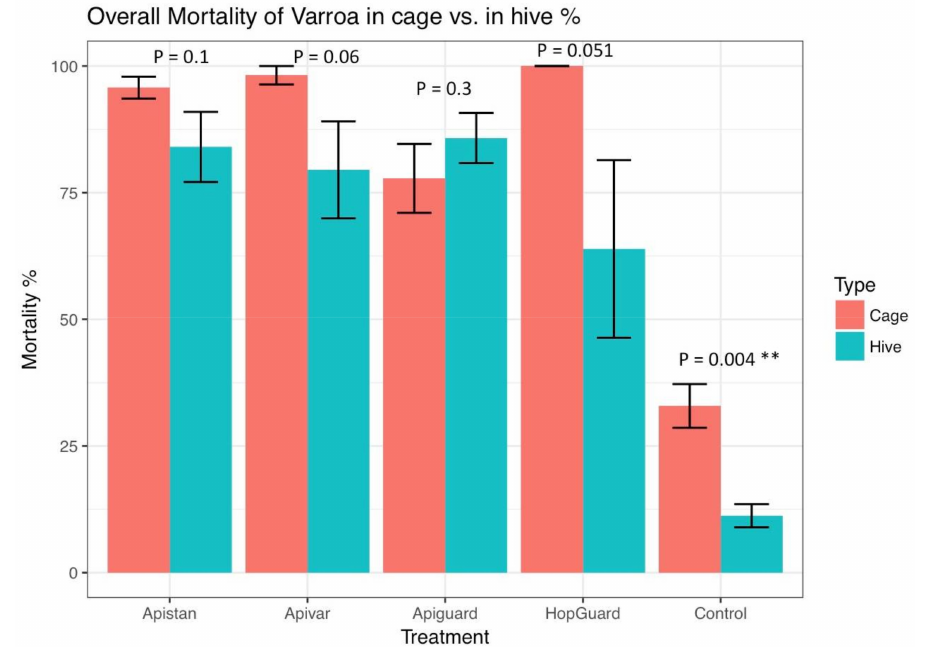
Figure 9. Comparative relative efficacy of Apiguard ® , Apistan ® , Apivar ® , and HopGuard ® applied to both caged bees and honey bee colonies, between 19 July and 18 August. All Varroa mites from the caged bees were counted after 48 h of exposure and after the final CheckMite ® application in colonies. Bars indicate mean ± 1 standard error (SE). ANOVA significant level is p < 0.01